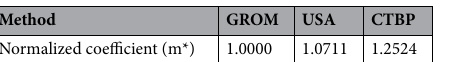
Table 3. Comparison of analytic solution